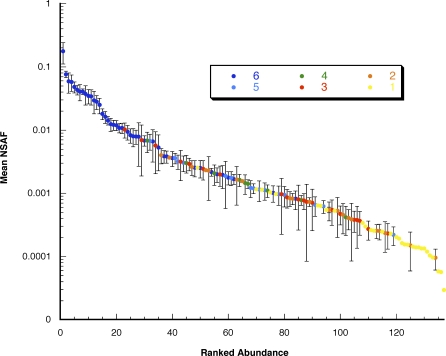
Relative Quantification of Transferred Sfps Found in Mated Female D. melanogaster in a Total of Six Canton S and tudor ExperimentsThe NSAF was used to estimate the relative abundance for each identified Sfp within each mating experiments, and values for each protein were averaged across all experiments in which the protein was found. Proteins were sorted by abundance and plotted to show the dynamic range of proteins detected (about 103). The color of each point indicates the number of experiments in which the protein was identified; note that sperm-specific proteins could only be found in a maximum of three experiments (Canton S). Error bars represent one standard error of the mean NSAF.